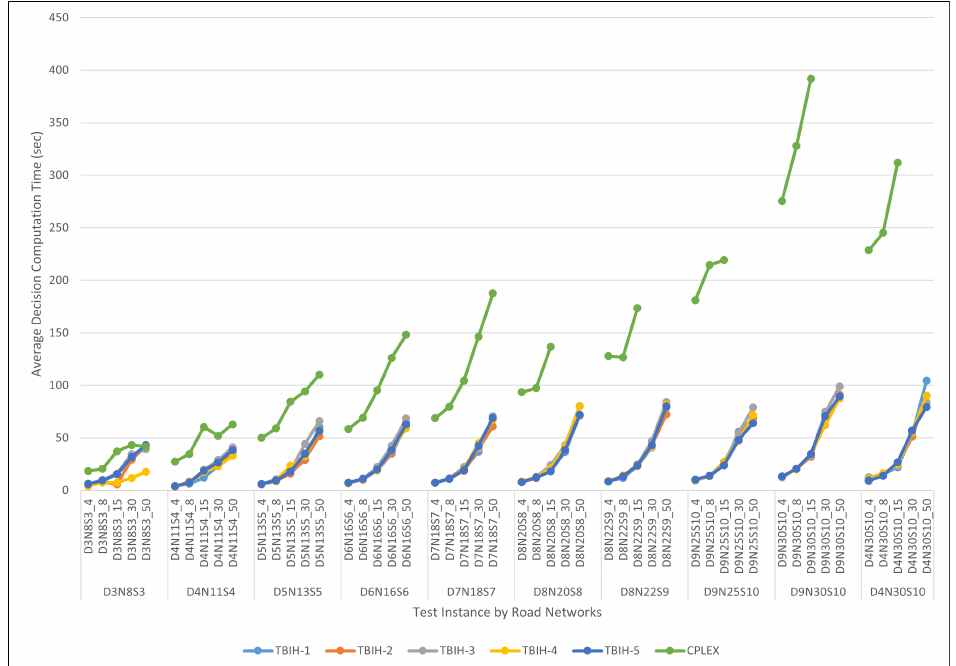
Figure A15. Algorithms performance compared to matheuristic rollout applied in PDS-RA: average decision computation time (sec) based on test